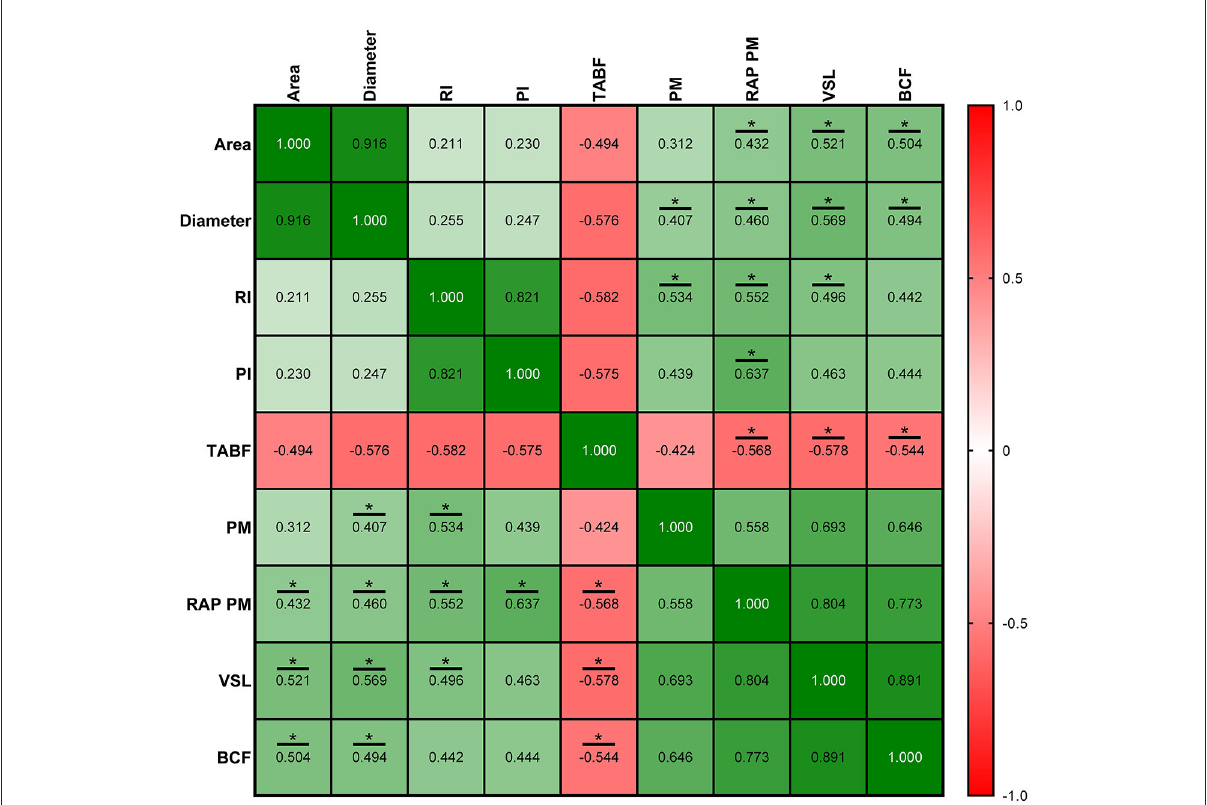
FIGURE9 Correlation coefficients between ultrasonography measurements and sperm quality parameters in standard semen collection frequency (SF). Area, proportion (%) of the total area corresponding with the lumen of the seminiferous tubules; Diameter, mean diameter ( µ m) of the lumen of the seminiferous tubules; RI, resistive index; PI, pulsatility index; TABF, total artery blood flow (ml/min); PM, progressive motility (%); RAP PM, rapid progressive motility (%); VSL, straight-line velocity ( µ m/s); BCF, beat frequency (Hz). The same 25 males were analyzed in each parameter. The R squared value between two parameters is represented in each cell and graph. In the correlation matrix, green color indicates positive correlations, and red color indicates negative relationships. The color intensity represents the strength of the correlation between two parameters. Asterisks show significant correlations ( P ≤ 0.05) between ultrasonography measurements and sperm quality